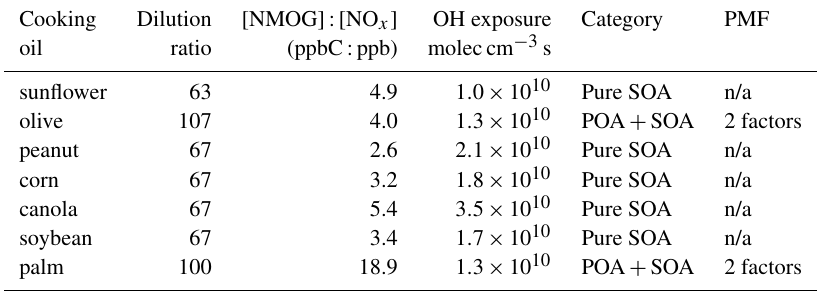
Table 1. Experimental conditions in the photochemical aging experiments. Cooking Dilution [NMOG]:[NO x ] OH exposure Category PMF oil ratio (ppbC:ppb) moleccm − 3 s sunflower 63 4.9 1 . 0 × 10 10 Pure SOA n/a olive 107 4.0 1 . 3 × 10 10 POA + SOA 2 factors peanut 67 2.6 2 . 1 × 10 10 Pure SOA n/a corn 67 3.2 1 . 8 × 10 10 Pure SOA n/a canola 67 5.4 3 . 5 × 10 10 Pure SOA n/a soybean 67 3.4 1 . 7 × 10 10 Pure SOA n/a palm 100 18.9 1 . 3 × 10 10 POA + SOA 2